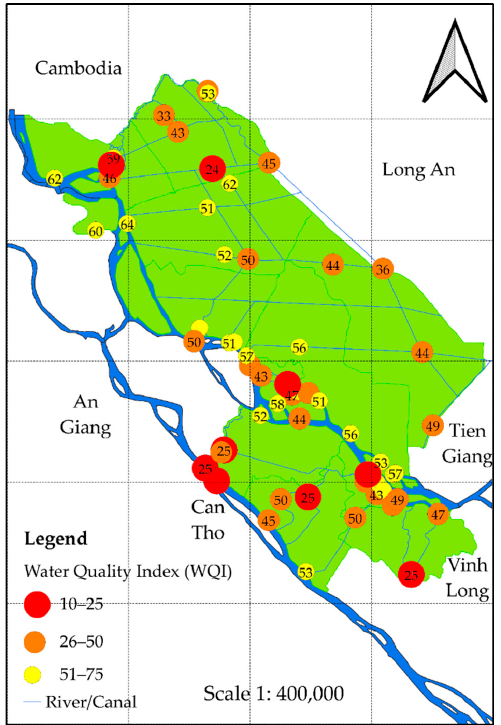
Figure 5. Map of water quality index in water bodies in Dong Thap province in 2019.